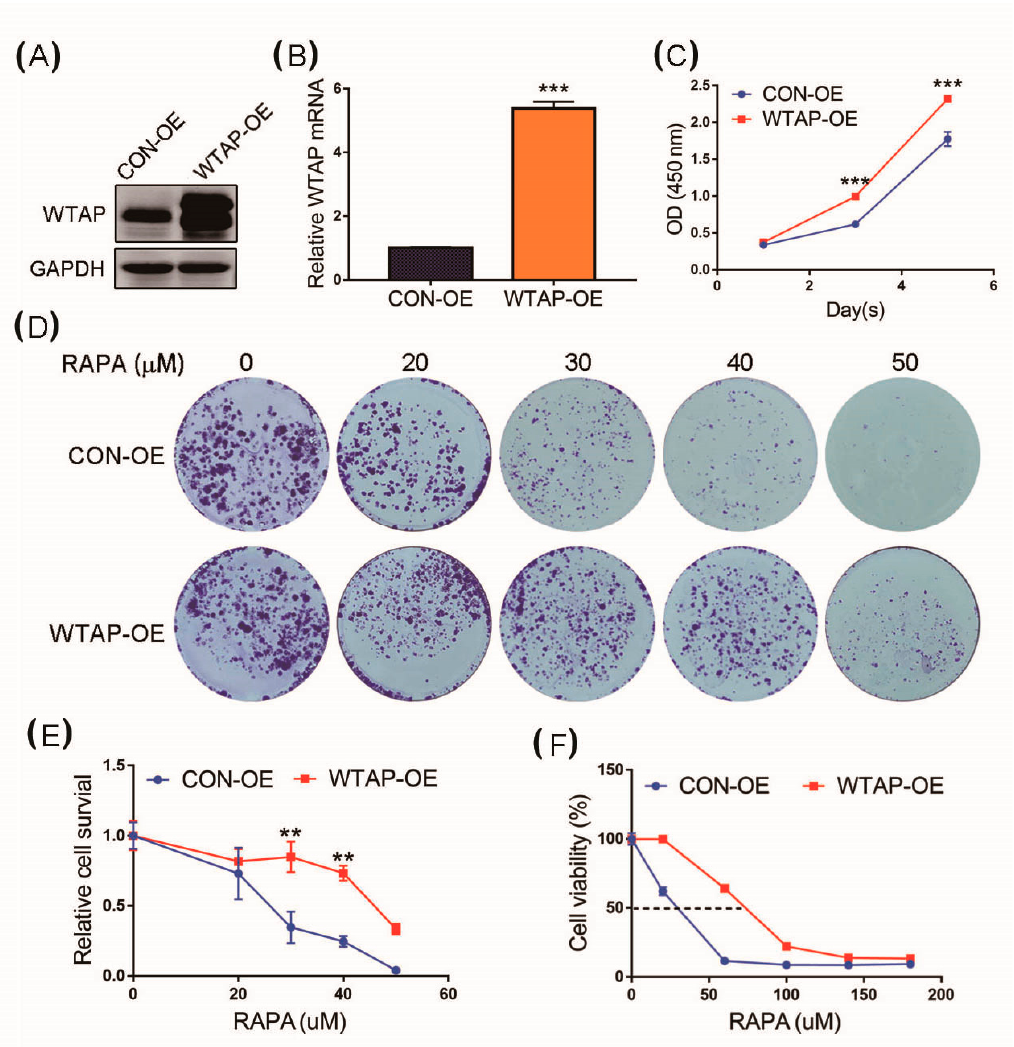
Figure 5. Effect of overexpression of WTAP on cell proliferation. ( A ) Western blot analysis of WTAP expressed in WTAP-OE and CON-OE cells. ( B ) RT-qPCR analysis of WTAP transcripts from WTAP-OE and CON-OE cells. ( C ) CCK-8 analysis was made to examine cell proliferation. ( D ) Colony formation analysis of WTAP-OE cells and CON-OE cells treated with different concentrations of RAPA. ( E ) Statistical analysis of cell survival of WTAP-OE cells and CON-OE treated with RAPA. ( F ) Statistical analysis of cell viability of WTAP-OE cells and CON-OE treated with RAPA. Error bars indicate the mean ± SD from three independent experiments ( n = 3). ** indicate a statistically significant difference ( p < 0.01), and *** indicates a statistically significant difference ( p <